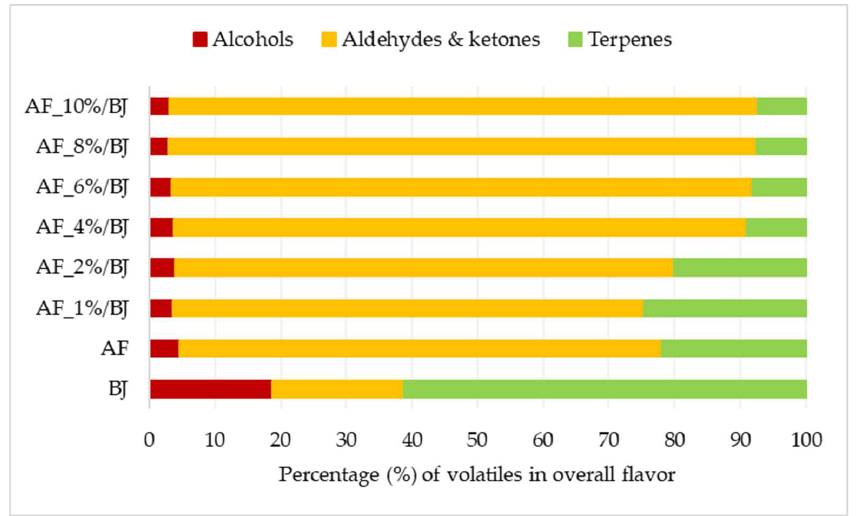
Figure 1. Percentage of different chemical classes of volatiles in overall flavor amount of blackberry